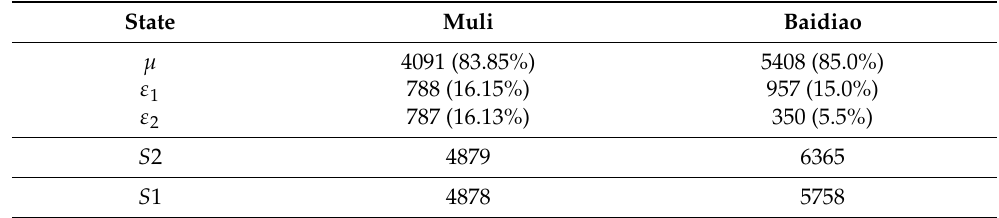
Table 2. The results of simulated Muli and Baidiao